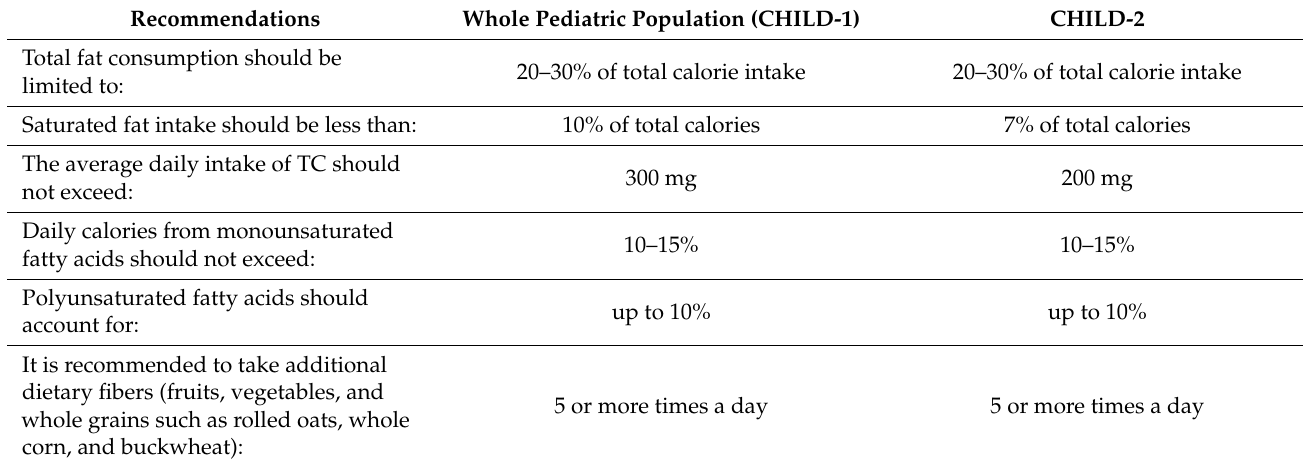
Table 4. CHILD-1 and CHILD-2 dietary recommendations by the National Cholesterol